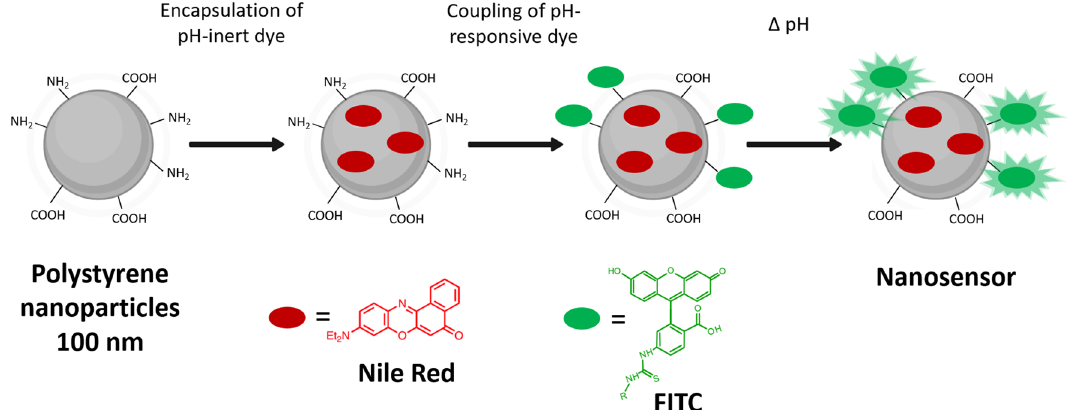
Figure 1. Schematic illustration of the nanosensor fabrication starting from a functionalized PS particle. NR is embedded into the particle by a swelling procedure and FITC is coupled to the PS NP by a thiourea